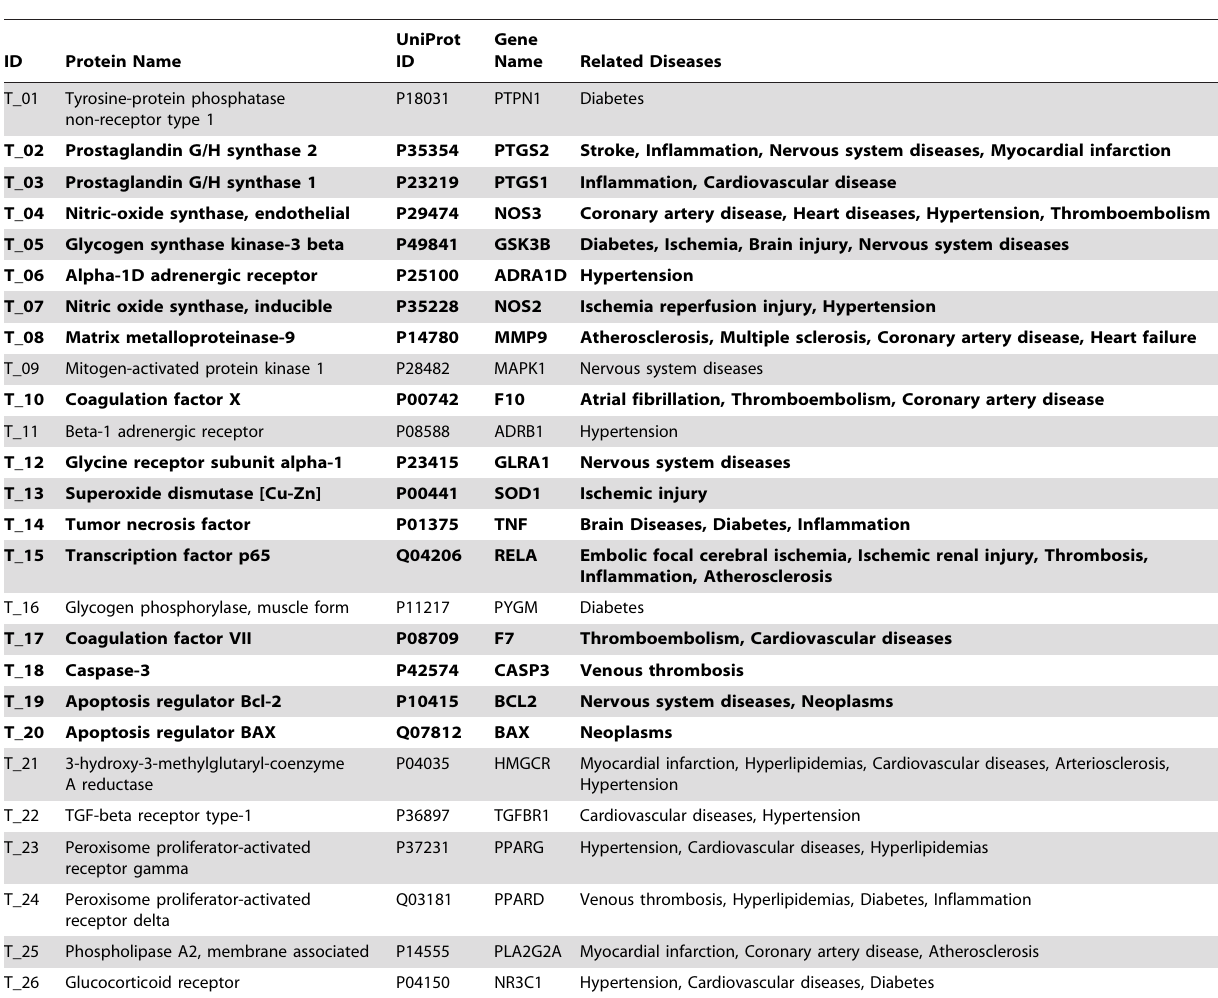
Table 2. The stroke-related targets of herbs and their corresponding diseases (Part